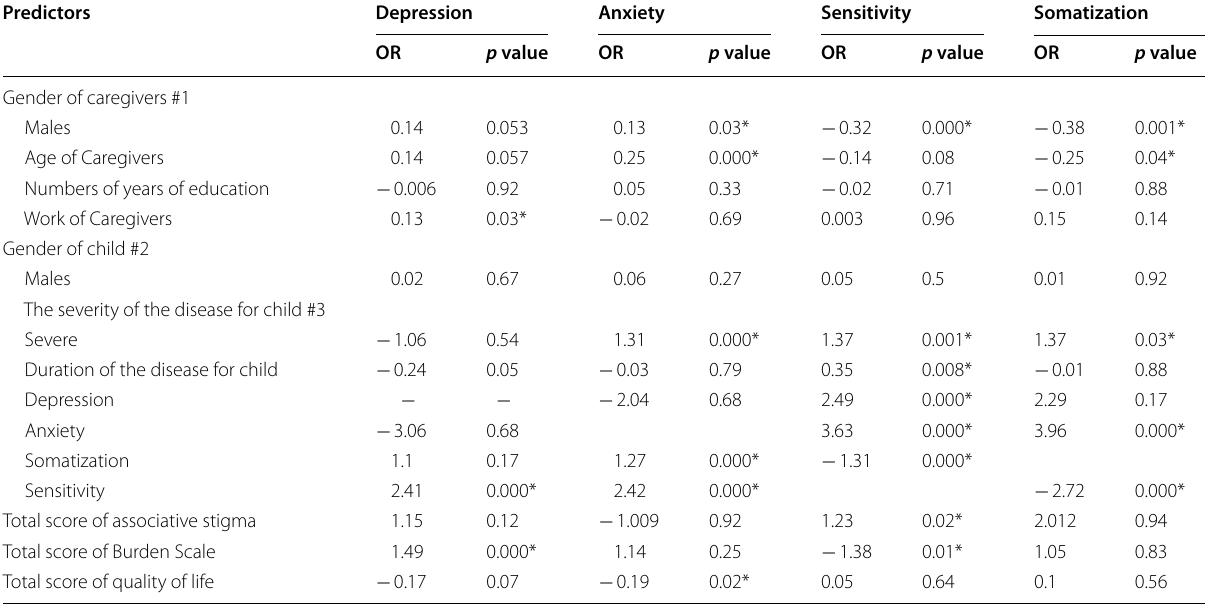
Table 4 Multivariate generalised regression model for parent mental health problems of autistic